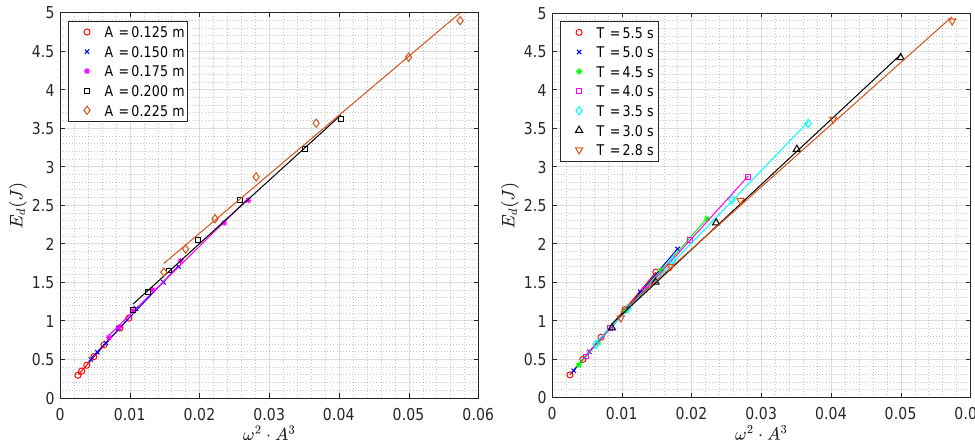
Figure 16. Dissipated energy under the imposed top-end motions for the mooring line without clumped